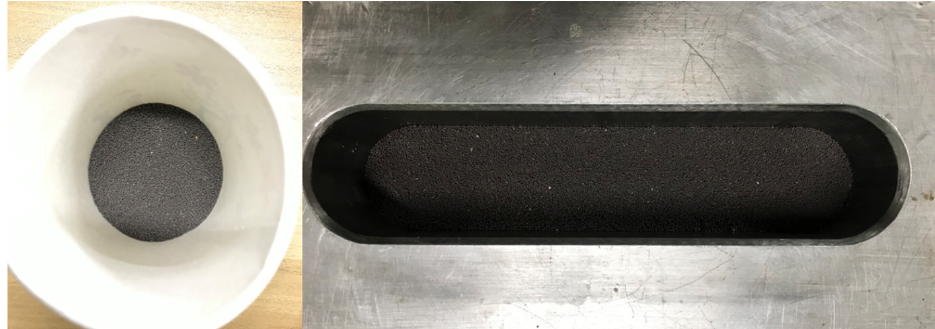
Figure 4. Pure proppant and its placement in the diversion chamber.